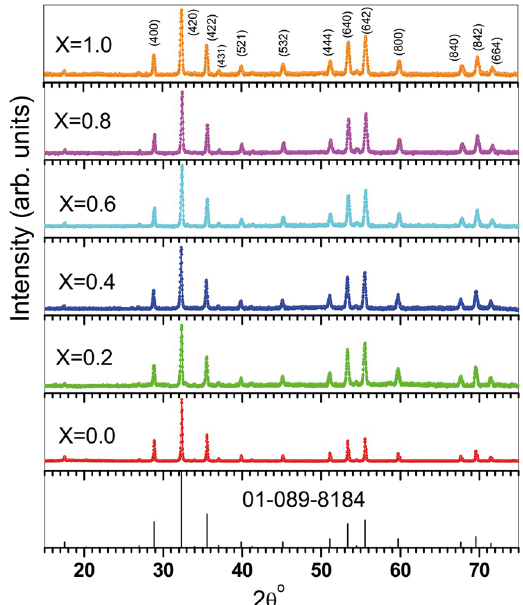
Al Fe O 3 x (5- x ) 12